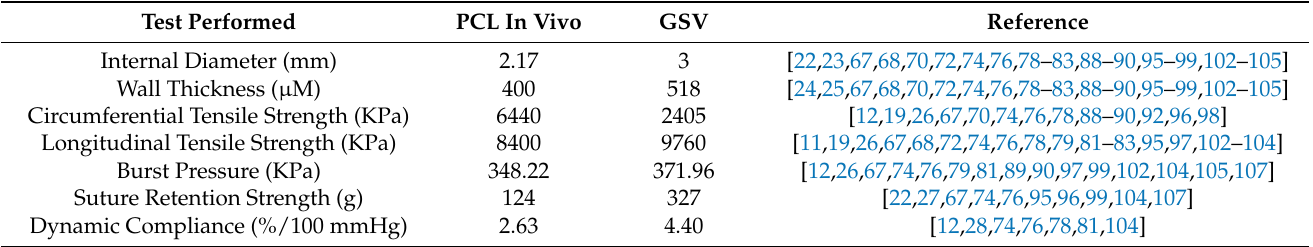
Table 5. Mechanical properties in blood vessels: Poly( ε -Caprolactone) tested in vivo (PCL in vivo) and great saphenous vein